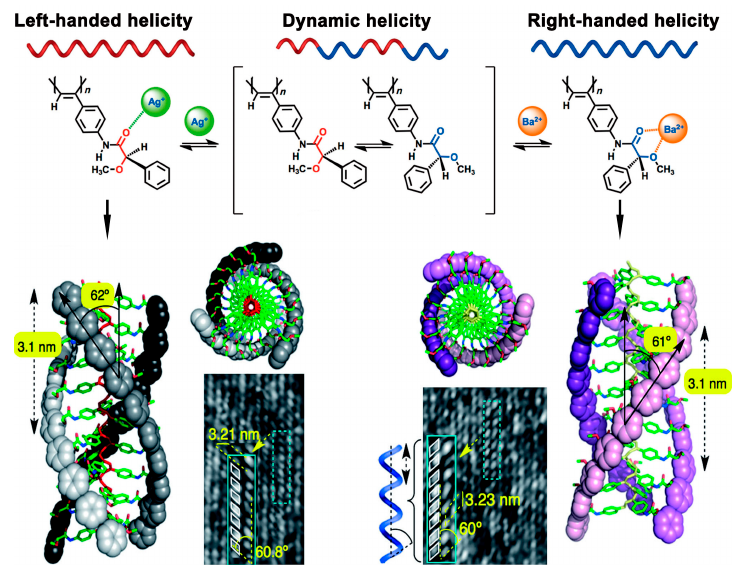
Figure 5. Scheme illustration of selective regulation of the helix sense by control of the conformation of the pendants upon Ag + or Ba 2+ , respectively (upper part); AFM images and theoretical models (form the top and side views) of left-handed helix of polymer/Ag + , or right-handed helix of polymer/Ba 2+ (lower part). Reproduced from [23] with copyright permission.